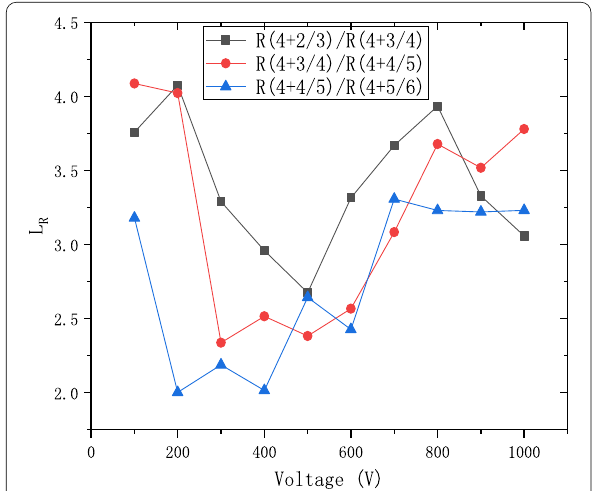
Fig. 9 The resistance of the step length L R with the voltage diagram at the different ratio of the working resistance of neighbor formula